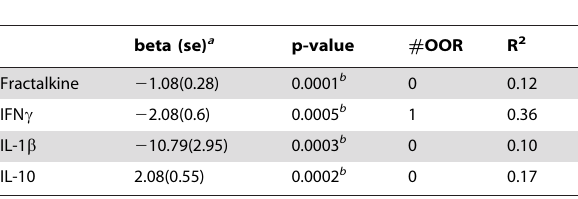
Table 2. Correlation of syndecan-1 to cytokines.